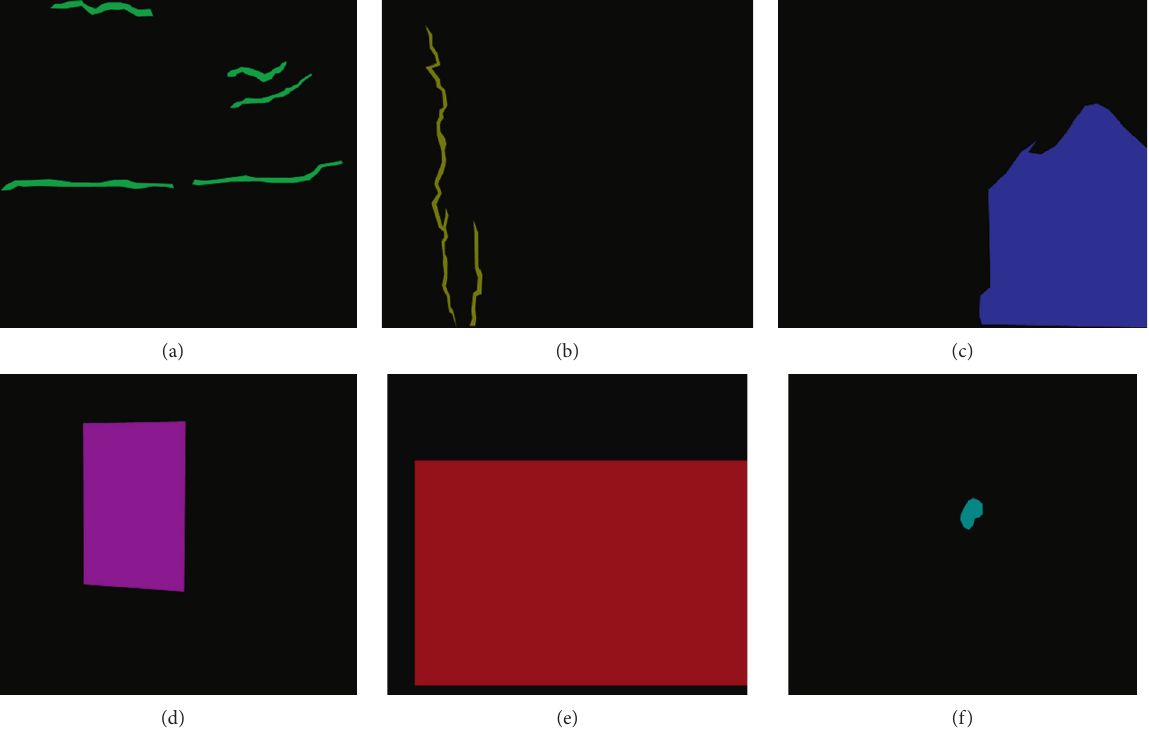
Figure 2: Six types of pavement distress. (a) Transverse crack. (b) Longitudinal crack. (c) Alligator crack. (d) Patch. (e) Block crack. (f)